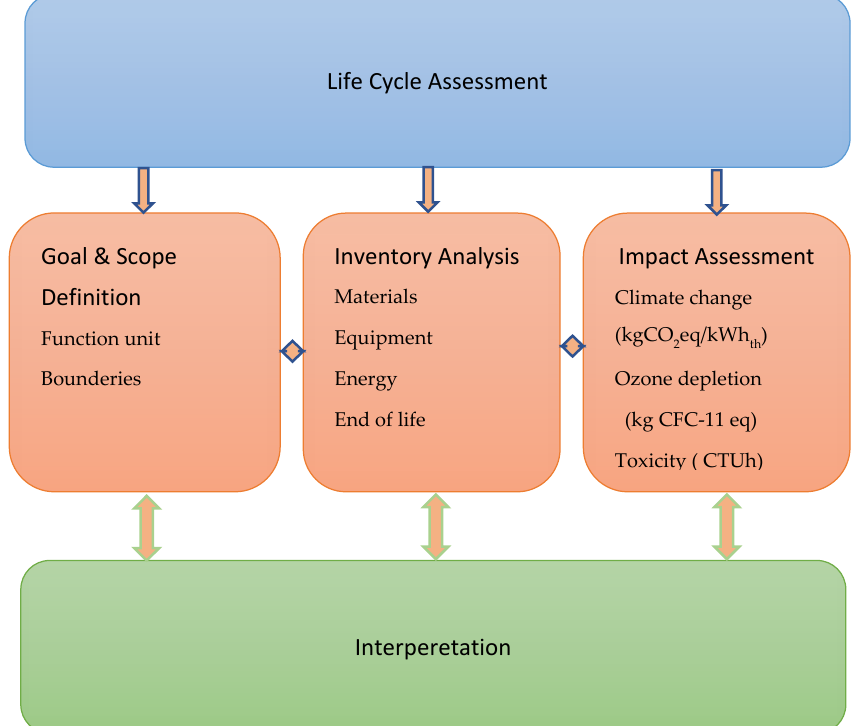
Figure 10. Stages of life cycle assessment.